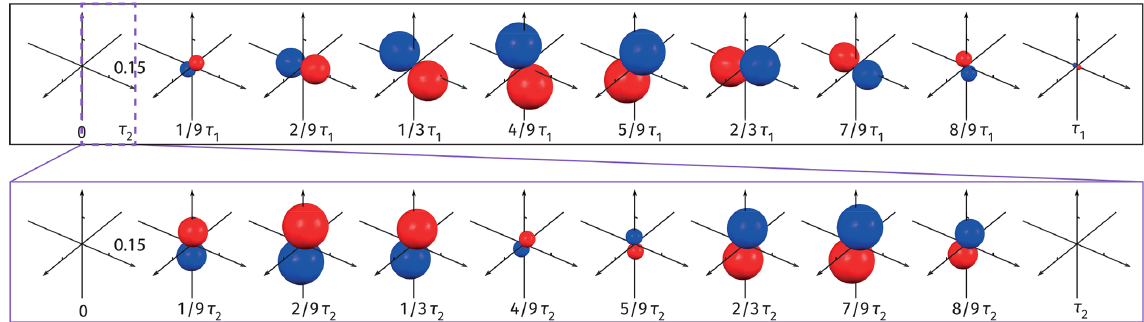
Figure H1. Visualizations of spin dynamics in an AX system ( 1 H– 13 C nuclear pair) during the zero- to ultralow-field (ZULF) nuclear magnetic resonance experiment given the same conditions used in Fig. 5. Surfaces are plotted with the measurement operator over a timescale τ 1 ; the inset shows the evolution of the surfaces over a shorter timescale τ 2